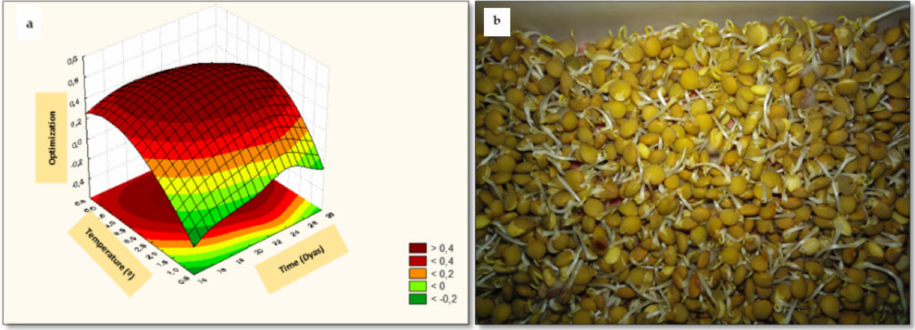
Figure 12. Three-dimensional response surface plots for desirability function ( a ) and image of germinated flour at optimal condition ( b